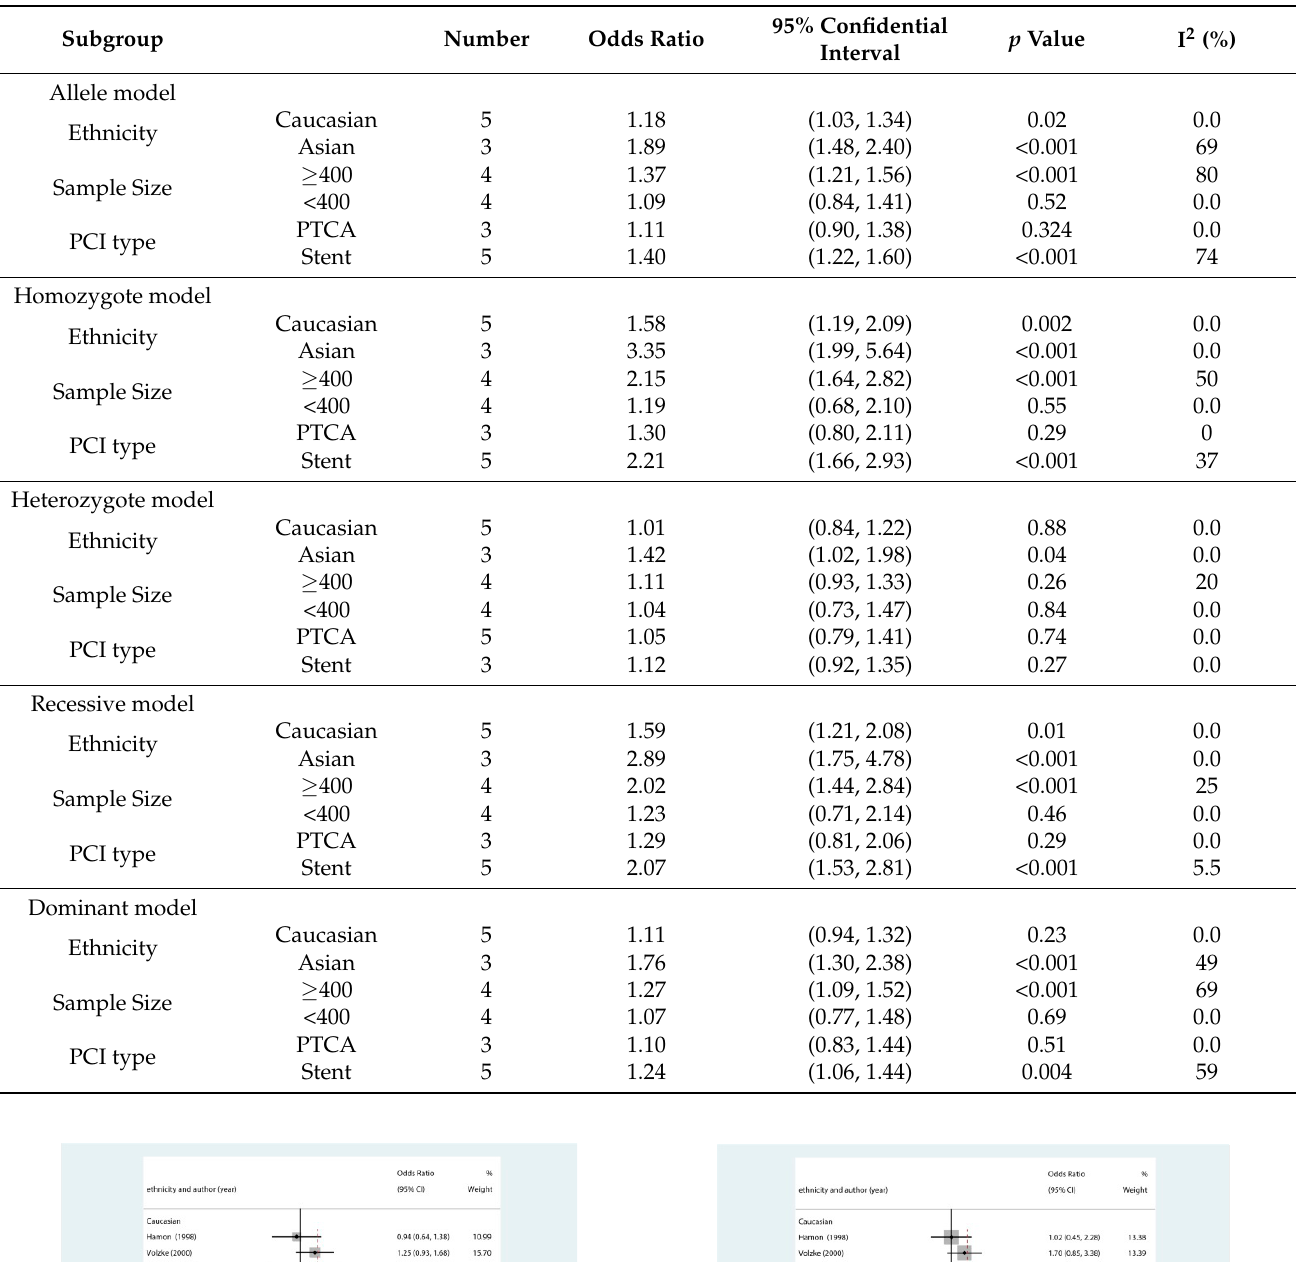
Table 4. Subgroup analyses of the association between AGTR1 rs5186 polymorphism and